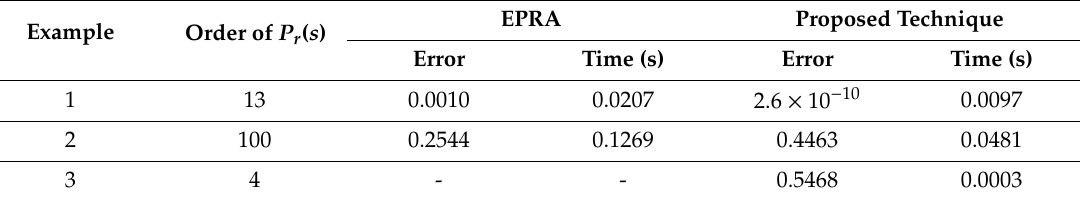
Table 1. Comparison of weighted error W o ( s )[ P ( s ) − P r ( s )] and simulation time.